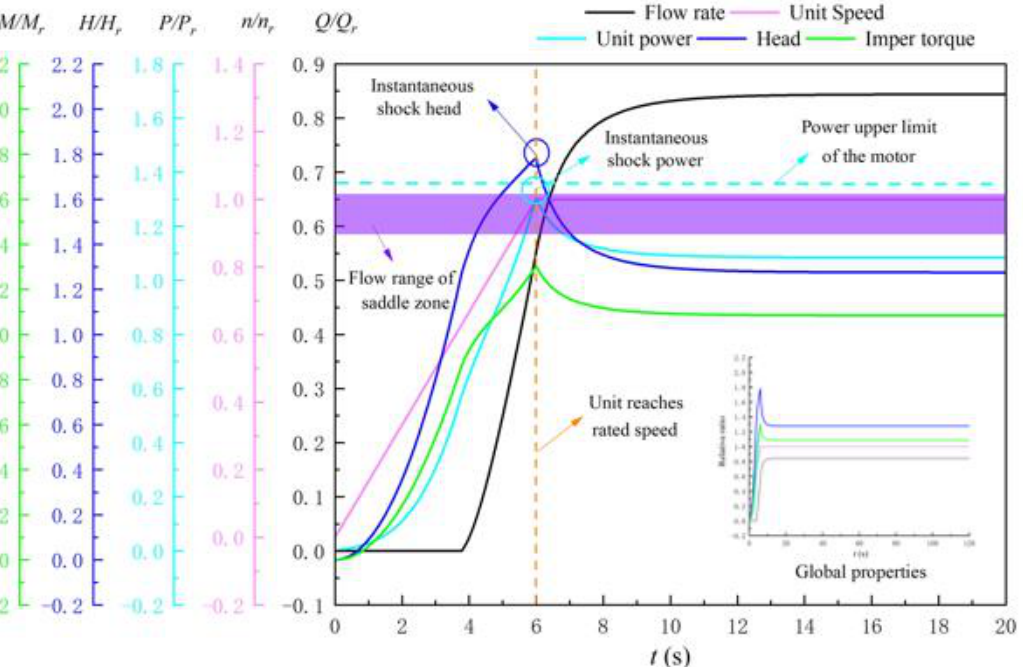
Figure 15. Flow at OVHO (1.04 H m ) and FLVA (49.1% A g ). 5.4. Gate Refusal Working Condition and Limited FLVA Area As both FLVA and OVHO are equipped, the actual project requires a comprehensive consideration of structural safety, construction difficulties, and other factors, which often leads to limitations for FLVA or for the elevation of the OVHO. Therefore, when the size of an auxiliary safety facility is limited, it is often necessary to coordinate with another safety facility to ensure the safety of LAPS start-up processes. This section is based on the premise that FLVA area settings are limited. The numerical simulation of the start-up pro- cess under gate refusal working conditions is performed for LAPS equipped with a 1.0 m 2 (7.5% A g ) FLVA and different elevations of OVHO. Auxiliary OVHO elevations include 5.55 m, 5.85 m, 6.15 m, 6.45 m, and 6.75 m, corresponding to 1.04, 1.09, 1.15, 1.21, and 1.27